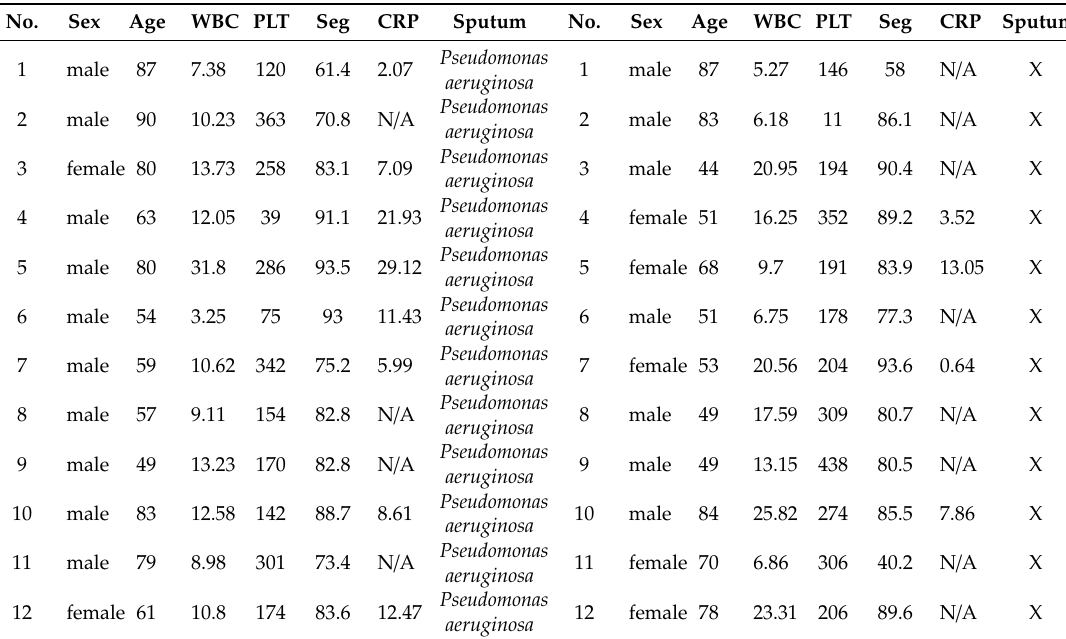
Table 2. Twelve patients with infection Pseudomonas aeruginosa and twelve patients of non-infection (WBC: White Blood Cell (10 3 / uL); PLT: Platelet (10 3 / uL); Seg: Segmented Neutrophils (%); CRP: C-Reactive Protein (mg / L); N / A: Not Available; and X: Non-infection